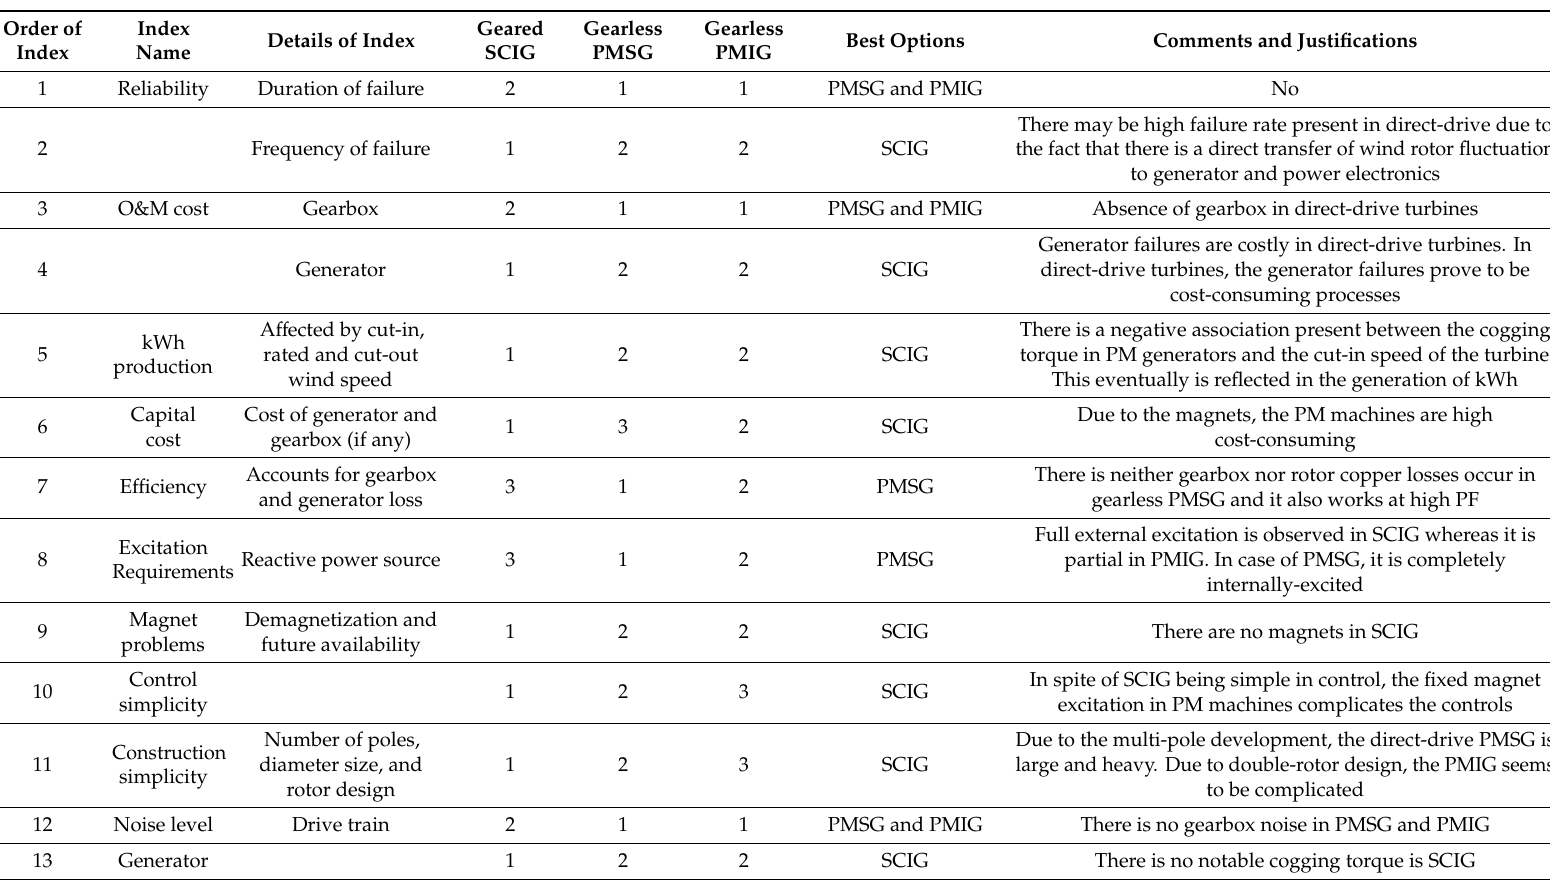
Table 1. Comparison of Geared-Drive Squirrel Cage Induction Generator (SCIG), Gearless-Drive Permanent Magnet Synchronous Generator (PMSG), and Gearless-Drive PMIG-Wind Energy Conversion System (WECS) configurations